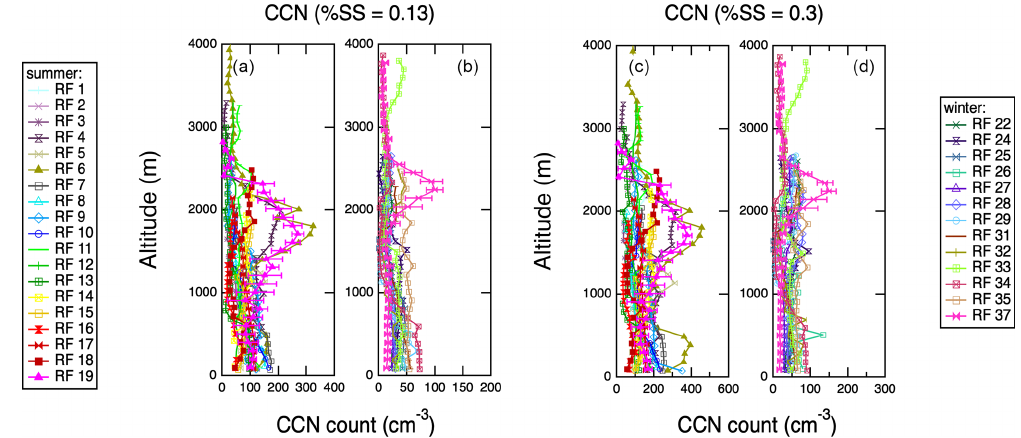
Figure 13. Vertical profiles of CCN concentration measurements at two supersaturations (0.13% and 0.3%) acquired during spiral profiles shown in Fig. S2. Representative error bars (1 σ standard deviations) are shown on 1d only for clarity. (a) CCN concentration at 0.13% supersaturation, IOP 1. (b) CCN concentration at 0.13% supersaturation, IOP 2. (c) CCN concentration at 0.3% supersaturation, IOP 1. (d) CCN concentration at 0.3% supersaturation, IOP